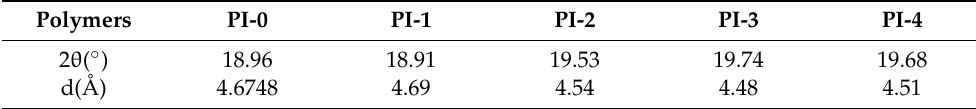
Figure 3. XRD of the PI films. Table 2. Diffraction peak and chain spacing of PI films. Table 2. Diffraction peak and chain spacing of PI